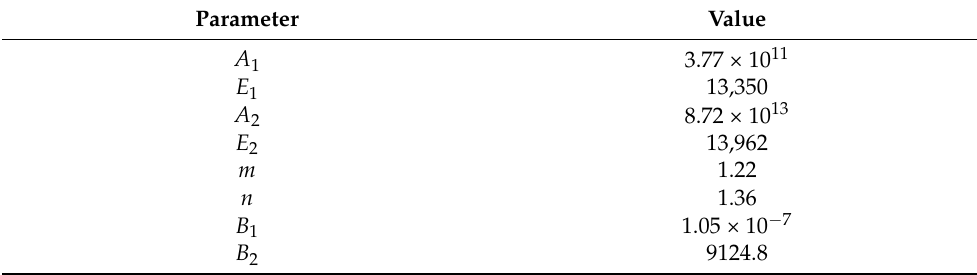
Table 2. Rubber characterization: Parameters of rubber cure kinetics.